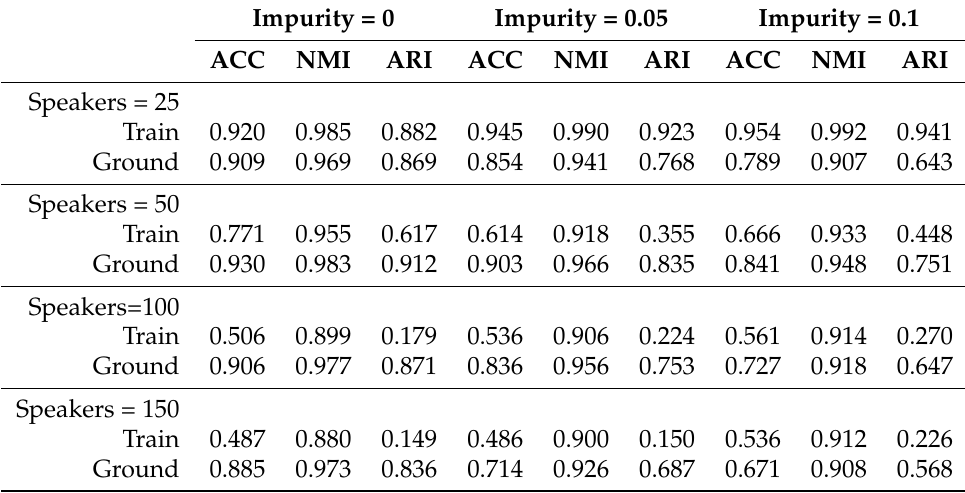
Table 5. The table benchmarks the pairwise architecture in ASR dataset with four groups of speakers, 25, 50, 100, and 150. For each group of speakers, the table also considers three segmentation impurities, 0, 0.05, and 0.1 to illustrate the shortcomings of incorrect segmentation, for fully unsupervised speaker recognition